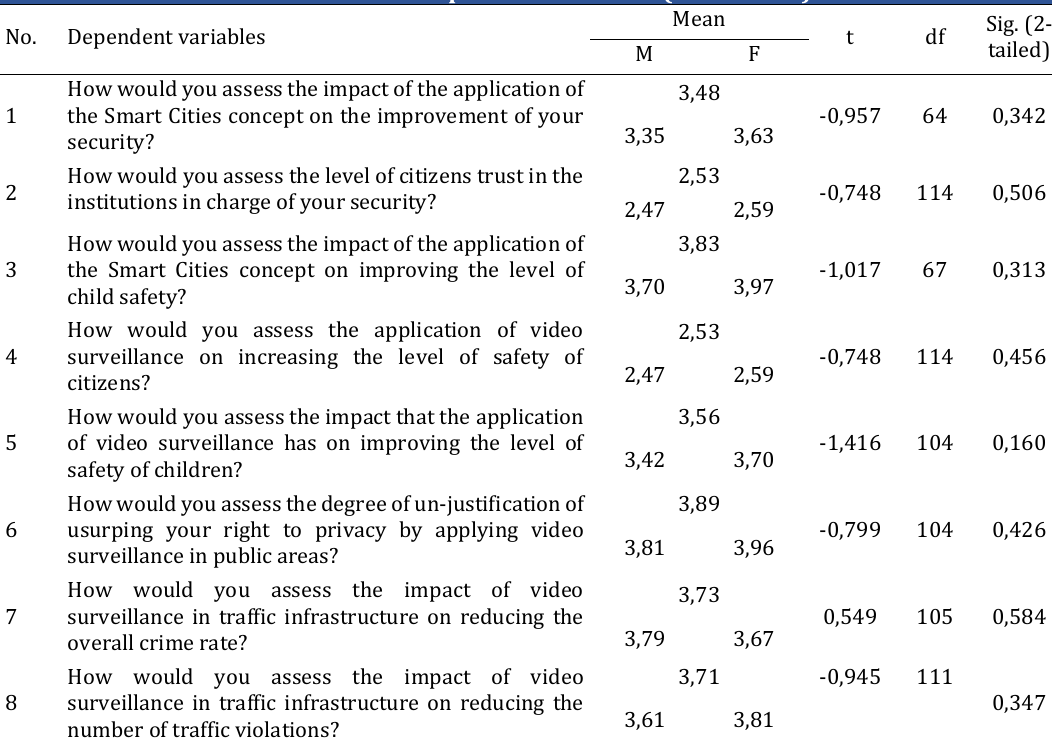
Table 3: Statistical characteristics of dependent variables (scale of 1-5)